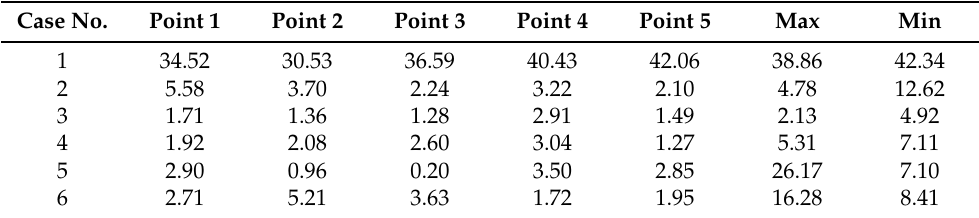
Table 3. Residual standard deviation.